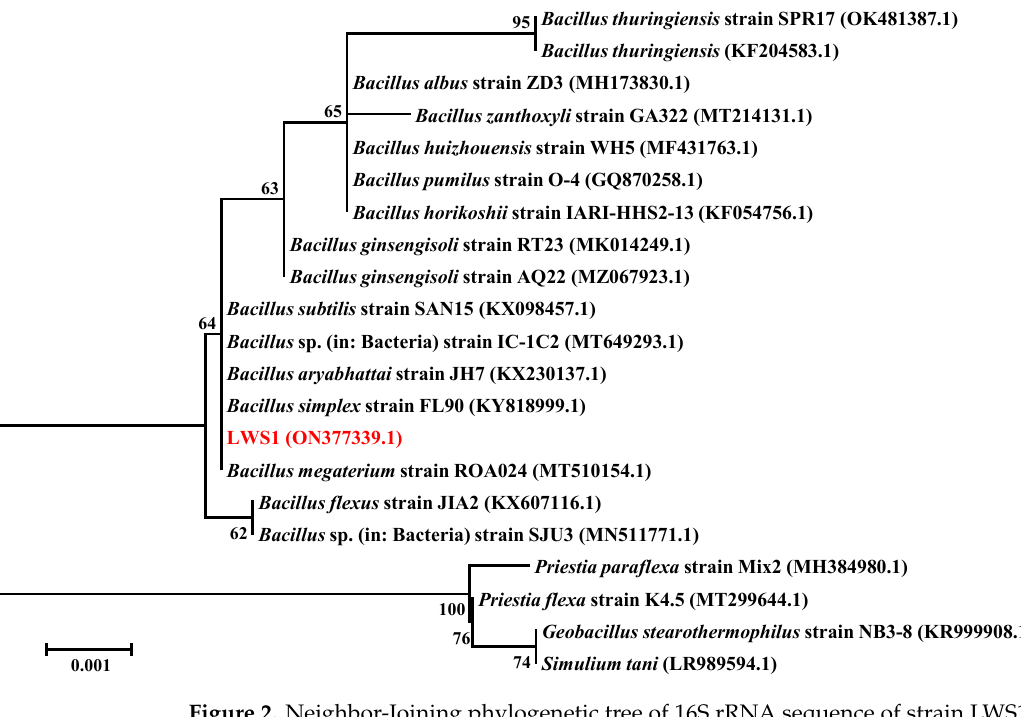
Figure 2. Neighbor-Joining phylogenetic tree of 16S rRNA sequence of strain LWS1 and reference sequences retrieved from NCBI database based on similarity analysis. The BLAST parameters included an expected threshold: 10, word size: 28, max matches in a query range: 0, match/mismatch scores: − 1 and − 2, gap costs: linear, filter: low-complexity regions and mask: lookup table only. The tree root was constructed with bootstrap values calculated from 1000 resamplings. The numbers at each node indicate the percentage of bootstrap supporting. The scale bar represents 10 substitutions per 100 bases. The sequence alignment and the phylogenic tree construction were performed by MEGA 6.0.